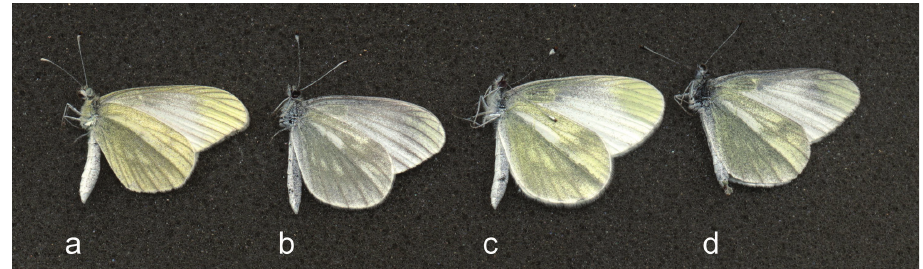
Figure 1. Spring brood males of four species of Leptidea Billberg, 1820: L. amurensis (Ménétriés, 1859) ( a ), L. morsei (Fenton, 1881) ( b ), L. sinapis (Linnaeus, 1758) ( c ) and L. juvernica Williams, 1946 ( d ), simul- taneously collected in the studied area at the border of Novosibirsk city and Berdsk town, West Siberia, Russia (after Ivonin et al. 2009). Note the difference in the shape of the fore wing